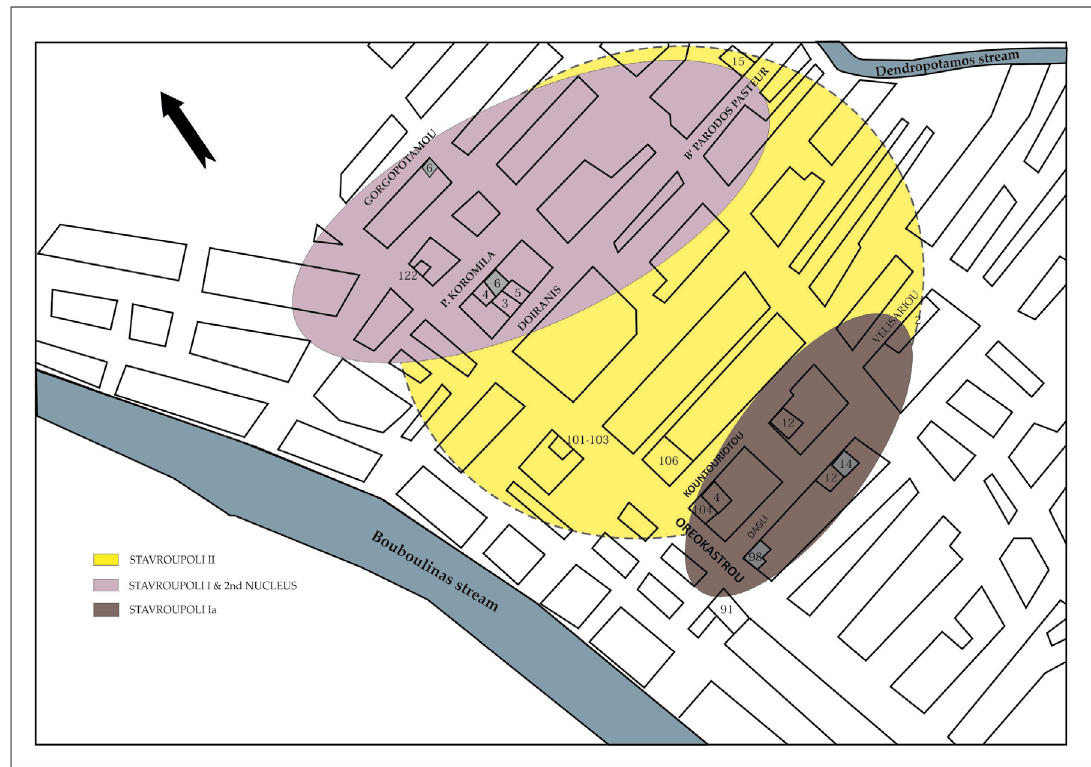
Figure 2. The urban plan of Stavroupoli with the excavated plots and the three phases of the settlement – Stavroupoli Ia, Stav- roupoli I and Stavroupoli II (see also Table